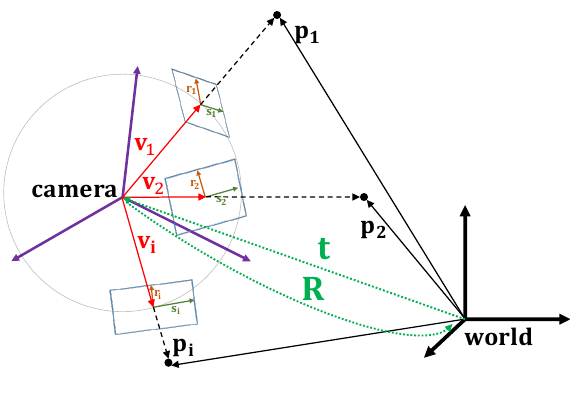
Figure 1. Observations of object points from a camera. The planes at each bearing vector v i are spanned by its respective null space vectors r i and s i